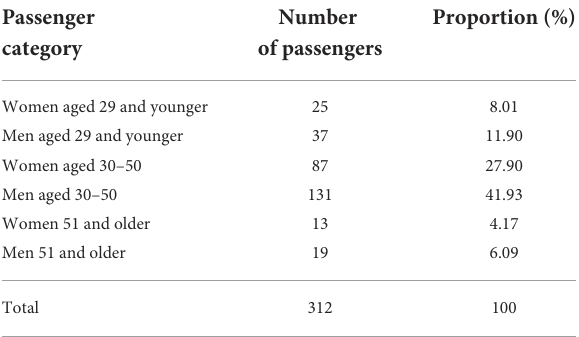
TABLE 7 The walking speed of different groups of people in the aisle when the cabin is horizontal (23).